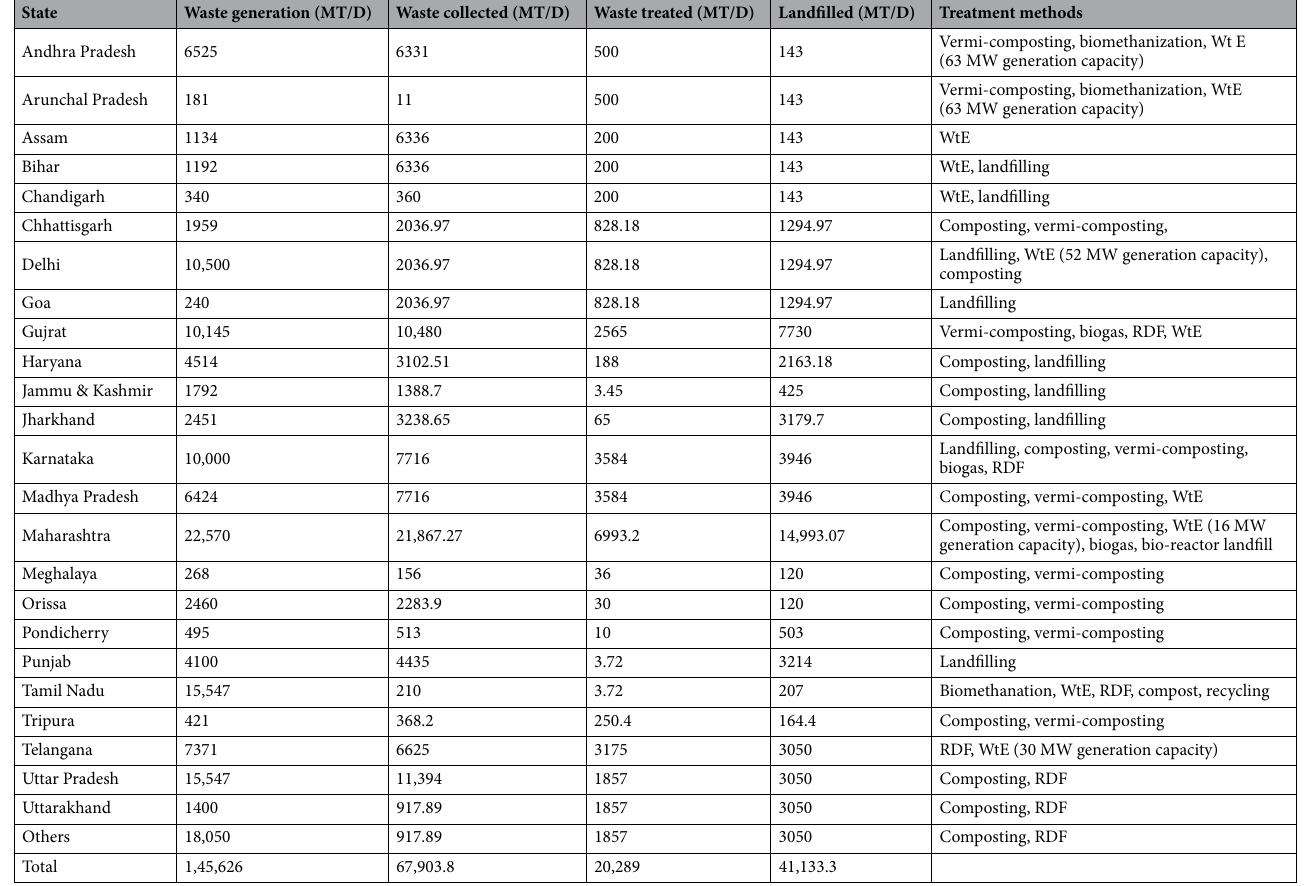
Table 1. Generation and handling of solid waste in urban areas of different Indian States 25